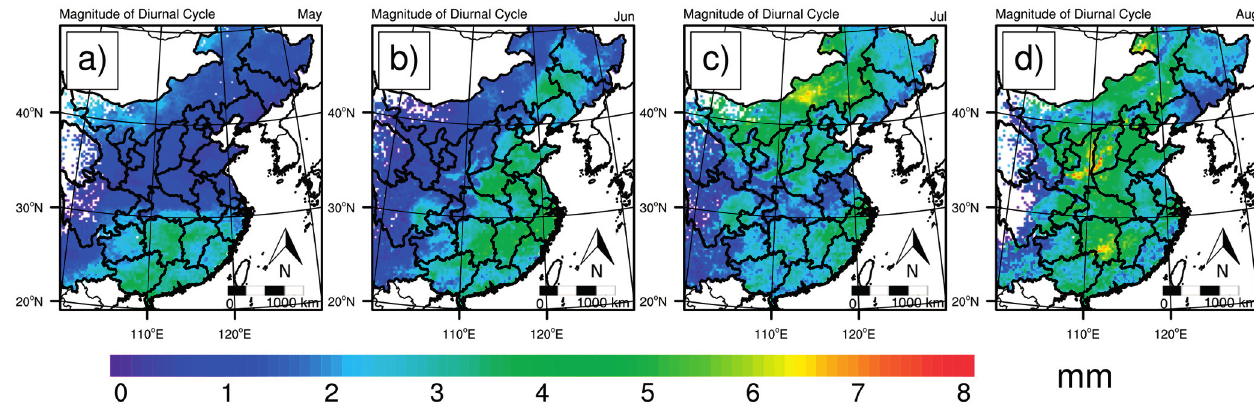
Figure 8. Magnitude of the diurnal cycle calculated from the reconstructed PWV data: ( a ) May; ( b ) June; ( c ) July; and ( d ) August. Missing data or pixels out of the national map boundary are indicated as white